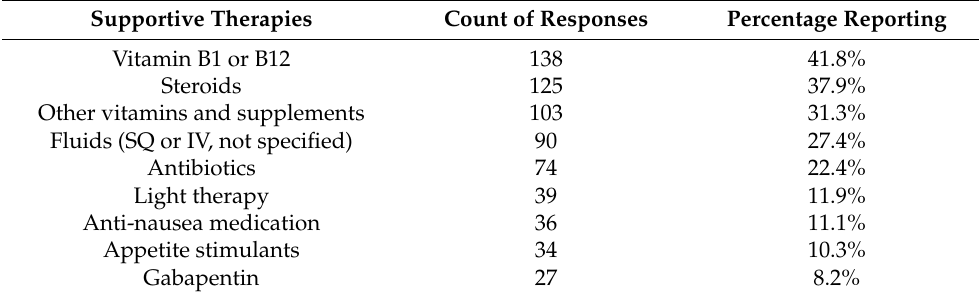
Table 6. Adjunctive therapies reported for cats treated with GS-441524. Owners were able to list more than one source, so the total number of responses is higher than the total number of respondents.